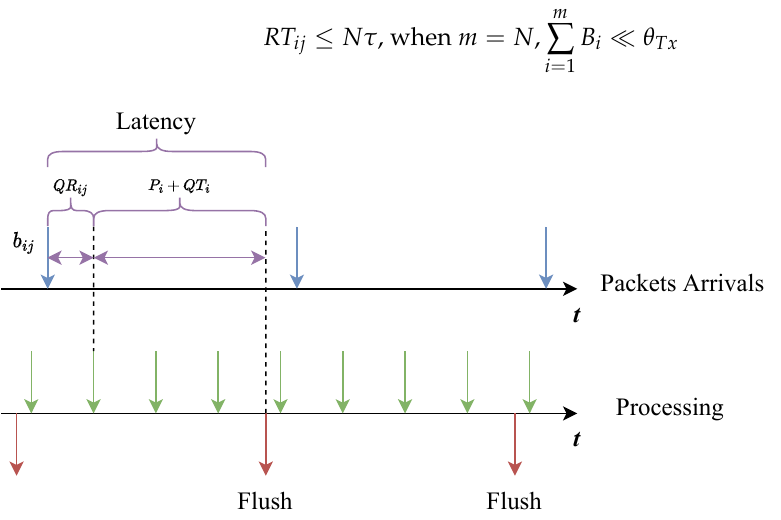
Figure 7. Schematic diagram of data plane behavior under low packet arrival